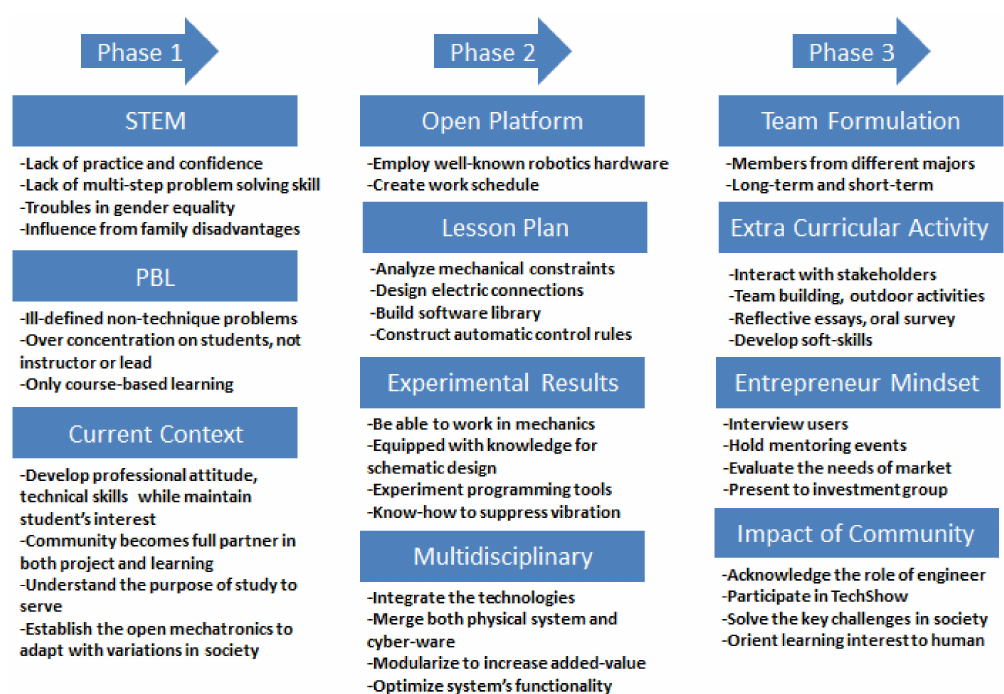
Figure 1. Overview of research framework. To illuminate the current issues in mechatronics education, Table 1 depicts the corresponding keys for each item. Our strategy is first to identify the limitations of teaching that are unfit in the present context. Then, a novel type of engineering education is proposed to alter the attitudes of both learners and instructors based on an “openness in design” mindset